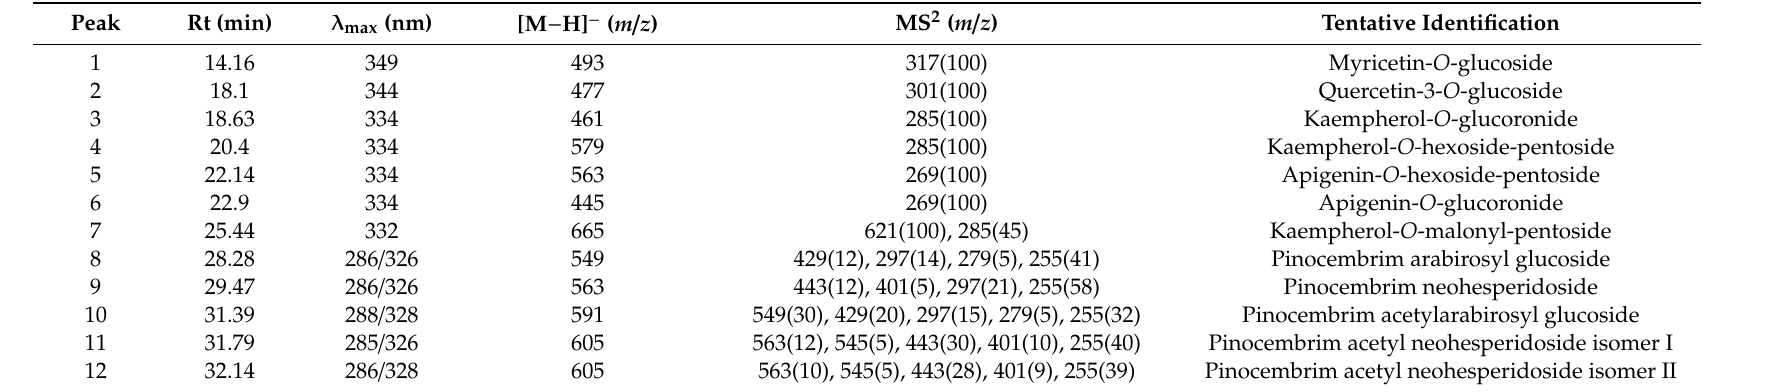
Table 7. Retention time (Rt), wavelengths of maximum absorption in the visible region ( λ max ), mass spectral data and tentative identification of the phenolic compounds present in the hydroethanolic extracts of Centaurea raphanina subsp. mixta leaves. Peak Tentative